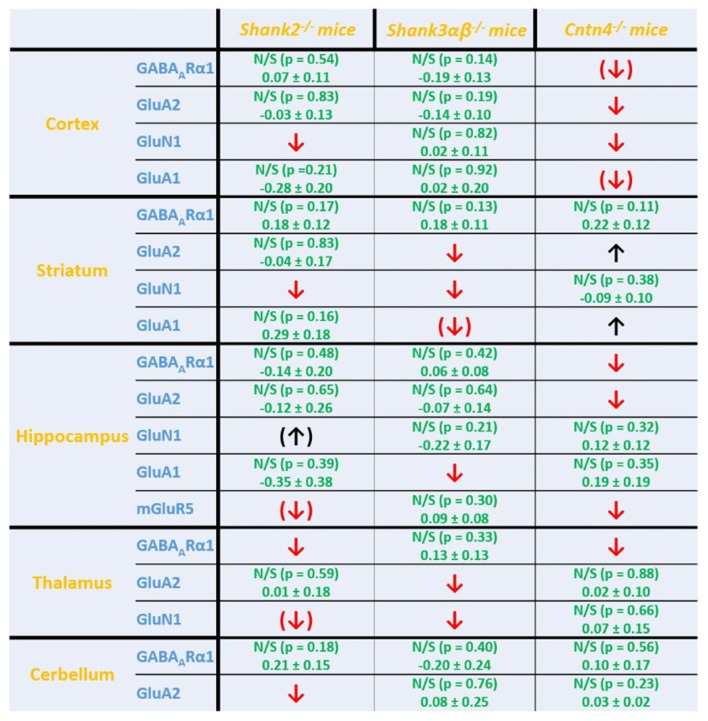
Summary of cell surface glutamate and GABA receptor subunit analysis in ASD related brain regions of Shank2−/−, Shank3αβ−/− and Cntn4−/− mice. Summarized cell surface glutamate and GABA receptor subunit analysis reveals a commonality of Shank2−/− and Shank3αβ−/− mice with respect to dysregulations of cell surface receptors relative to wildtype controls whereas Cntn4−/− mice appear to differ from the Shank deficient mice in this respect. On the whole, Shank2−/− and Shank3αβ−/− mice display reduced levels of cell surface glutamate receptor subunits in most of the analyzed brain regions, whereas dysregulation of cell surface GABAARα1 levels is minimal. In contrast, Cntn4−/− mice display dysregulations of both cell surface glutamate and GABA receptor subunits. Summary is based on quantifications of surface/total ratio (Figures 2–4). ↓, ↑ p < 0.05; (↓), (↑) p < 0.10. In the case of non-significant data (N/S) which does not show trends (p > 0.10) the difference of means (wildtype—autism mouse model) ± SEM and the corresponding p-value is shown. Numbers are rounded to two decimal places. Upregulated (↑); downregulated (↓).